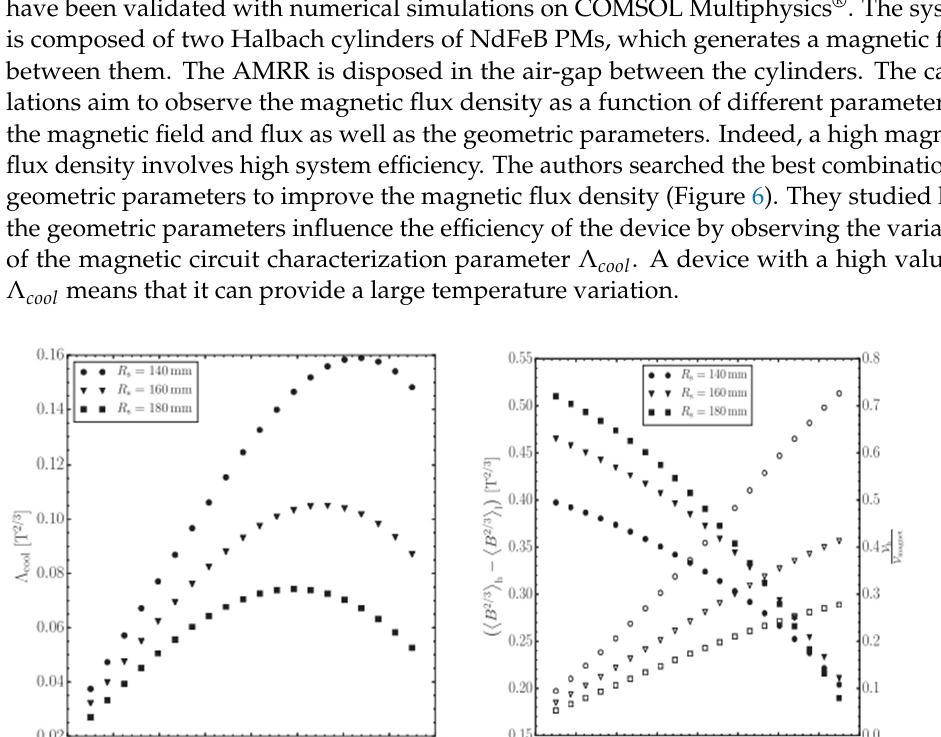
( b ) Figure 7. Comparison of the modeled and measured ( a ) adiabatic temperature and ( b ) isothermal entropy evolutions with temperature [43].